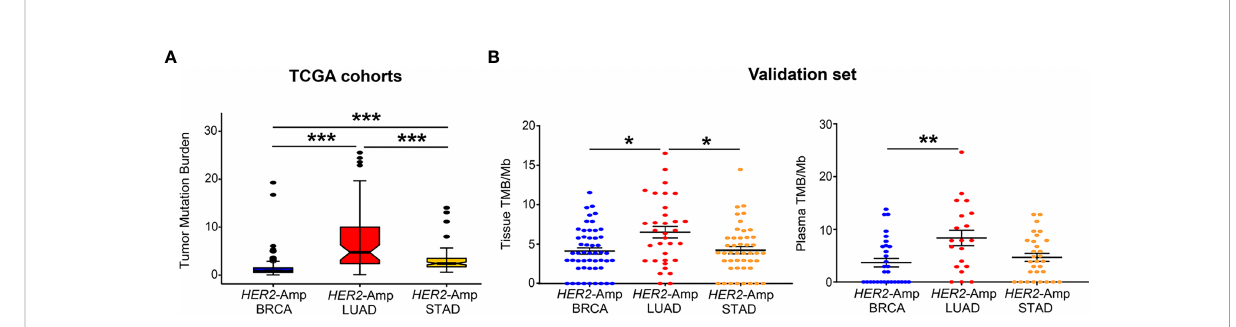
FIGURE 2 Correlation between HER2 ampli fi cation and TMB in patients with BRCA, LUAD and STAD. (A) Tissue TMB driven by HER2 ampli fi cation among three tumors from TCGA cohorts. (B) Tissue and blood TMB driven by HER2 ampli fi cation among three tumors from the validation set. TMB, tumor mutation burden, was de fi ned as the total number of somatic nonsynonymous per megabyte. P < 0.05 was regarded as signi fi cantly different. *** P < 0.001, ** P < 0.01, * P <